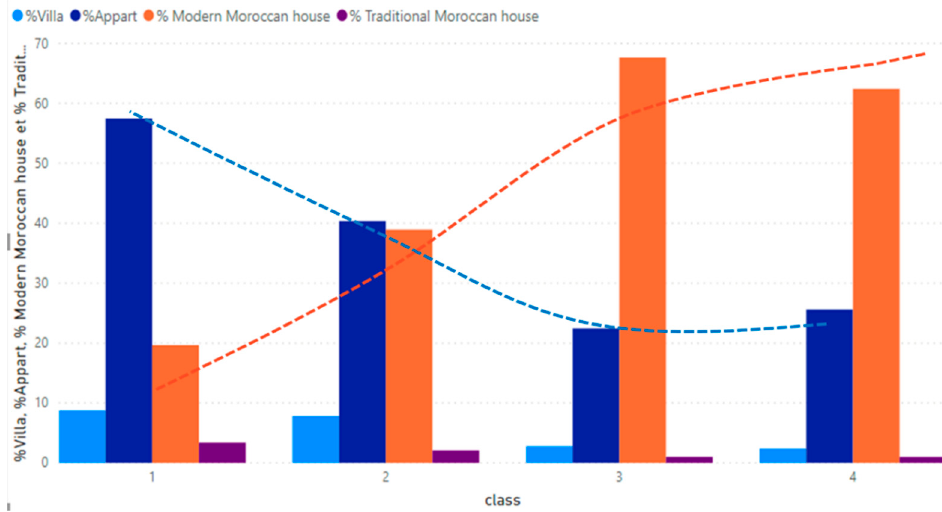
Figure 10. Dwelling type by social class.